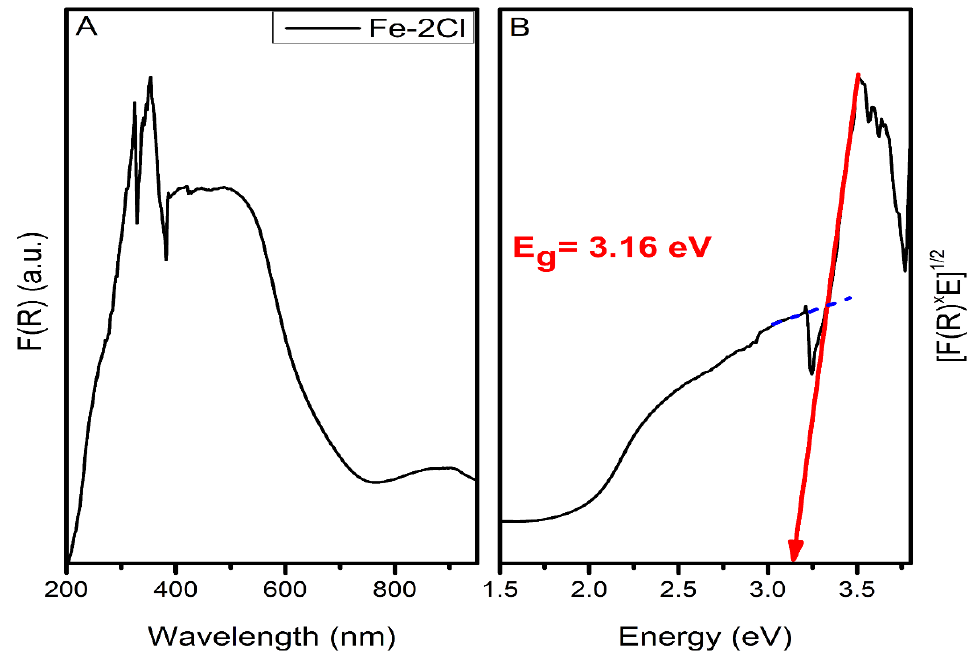
Figure 4. ( A ) Diffuse reflectance spectroscopy, F(R) versus wavelength, and ( B ) Tauc Plot Eg = 3.10 eV for Fe–2Cl catalyst. Table 1. Band Gap of catalyst.